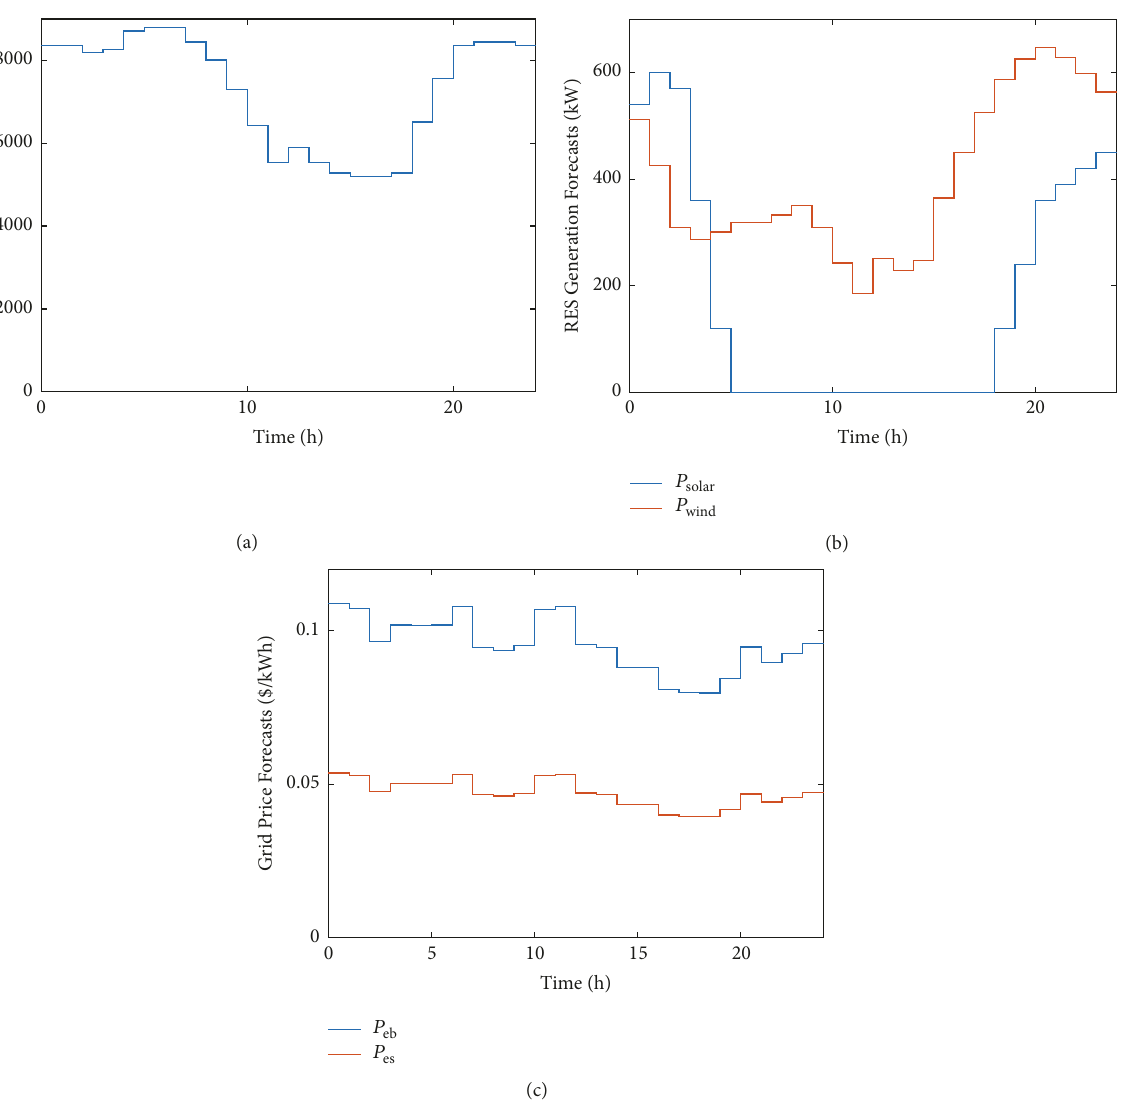
Figure 2: Forecasts of (a) load demand, (b) RES generation, and (c) electricity